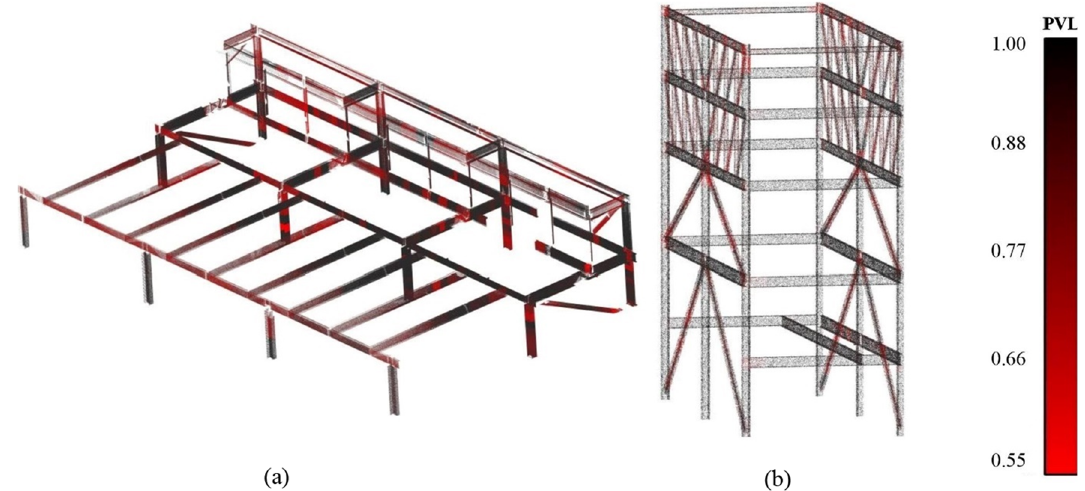
Figure 5. Probability vector length of the classified ( a ) multi-level carpark, and ( b ) Woodside